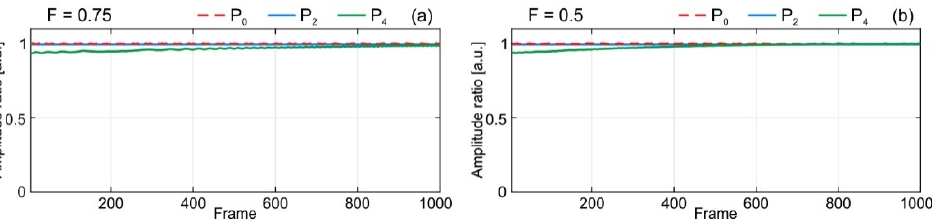
Figure 6. Amplitude ratios of reconstructed on-axis point P 0 , midpoint P 2 , and off-axis point P 4 from holograms made with update algorithm and A-PAS in 1000 cycle test for ( a ) F = 0.75, and ( b ) F =